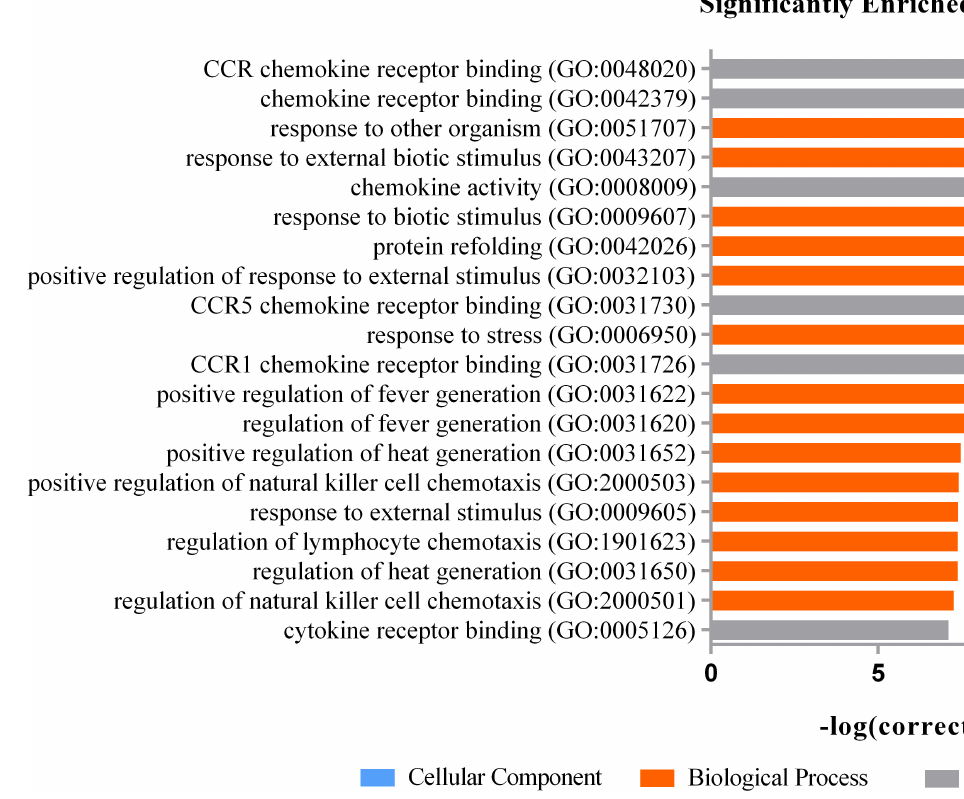
FIGURE 2 | The top 20 significantly enriched GO terms for the target gene of DEGs. Top 20 GO terms consist of biological processes and molecular functions, they are CCR chemokine receptor binding (GO:0048020), chemokine receptor binding (GO:0042379), response to external biotic stimulus (GO:0043207), response